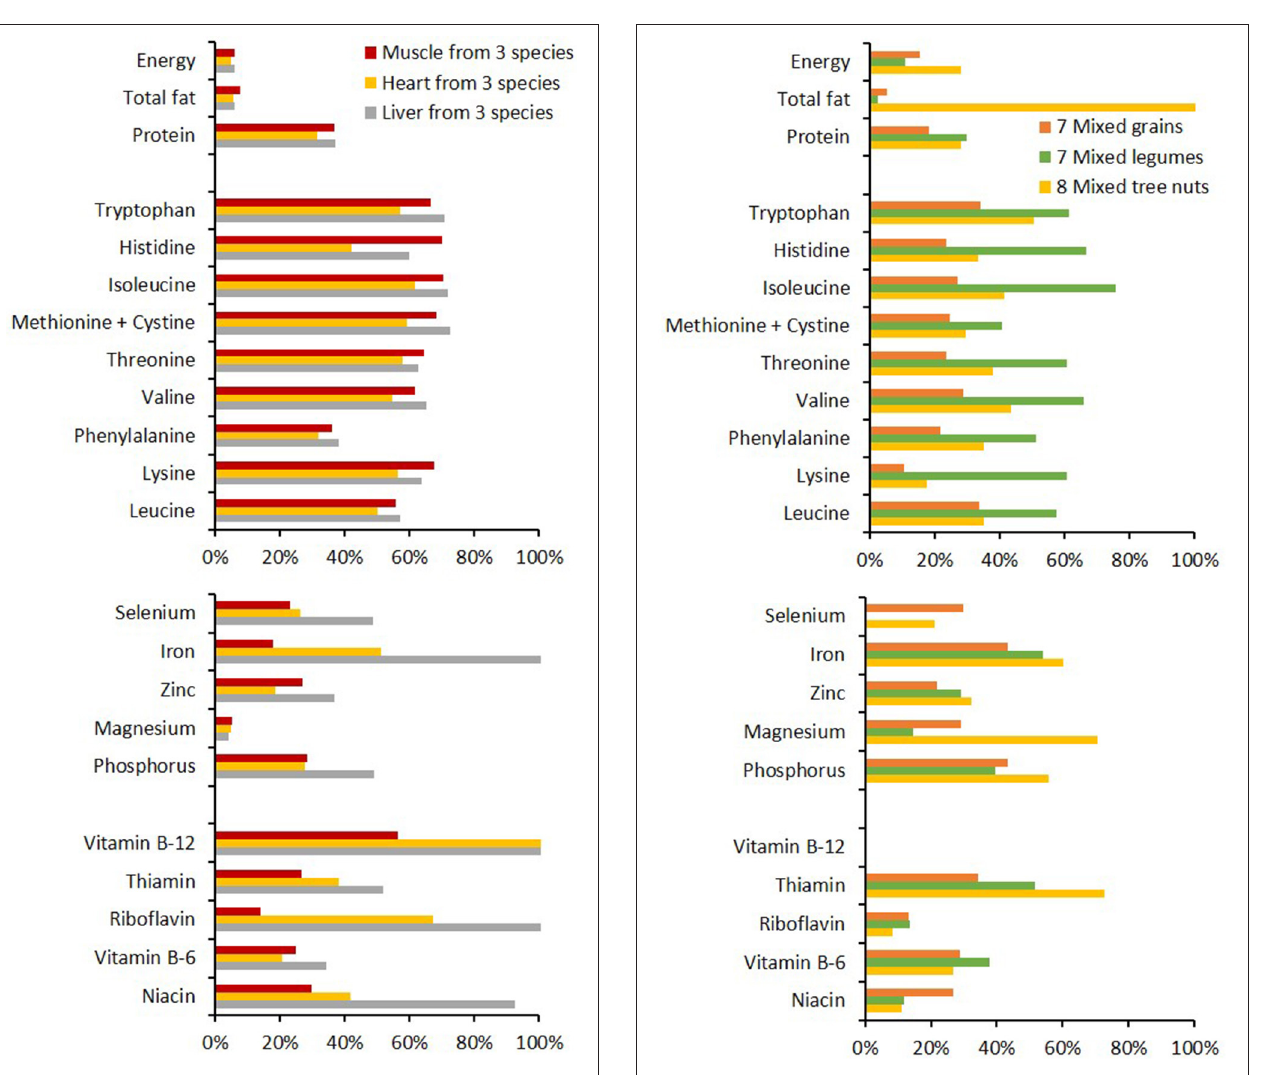
FIGURE 4 | Typical content of key nutrients in grains, legumes and tree nuts, shown here as the averaged values of 7–8 sources ( 78) and expressed as a proportion of the adult male RDA (66) that would be provided by a 100g raw serving. Items within nutrient classes are ordered by their increasing